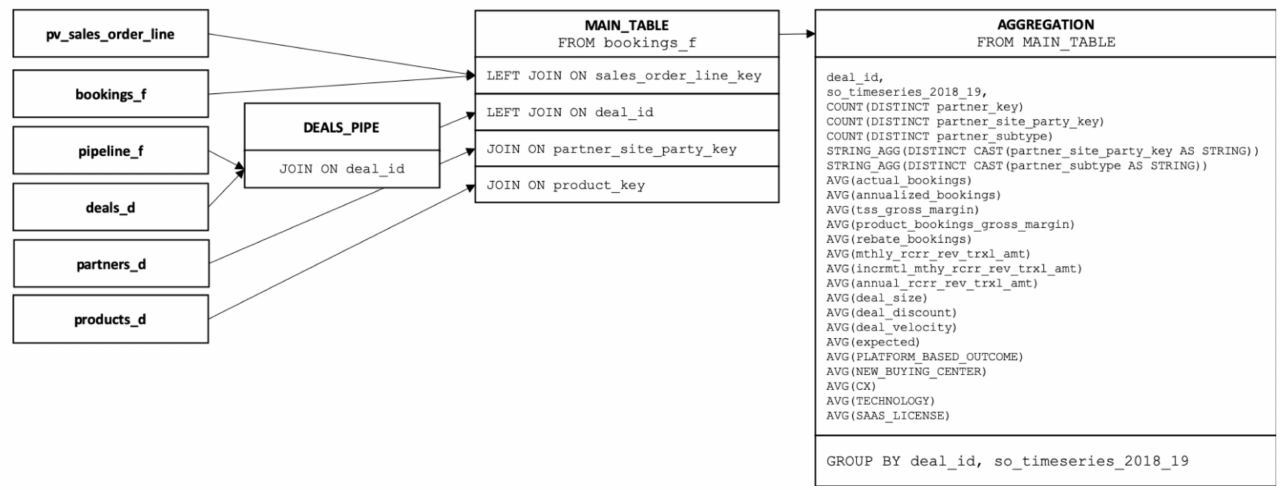
Figure 1. Indicators of partner